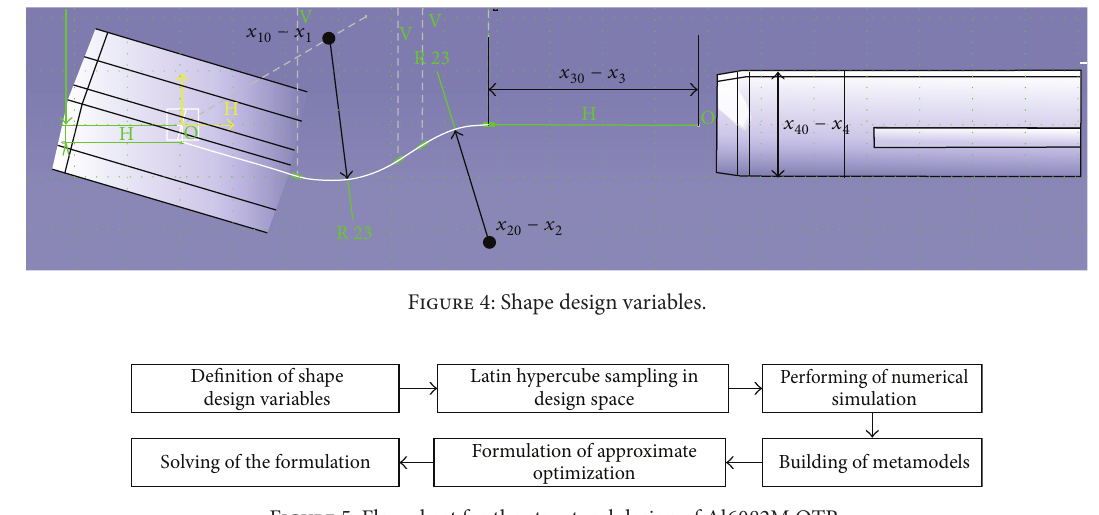
Figure 5: Flow chart for the structural design of Al6082M OTR.